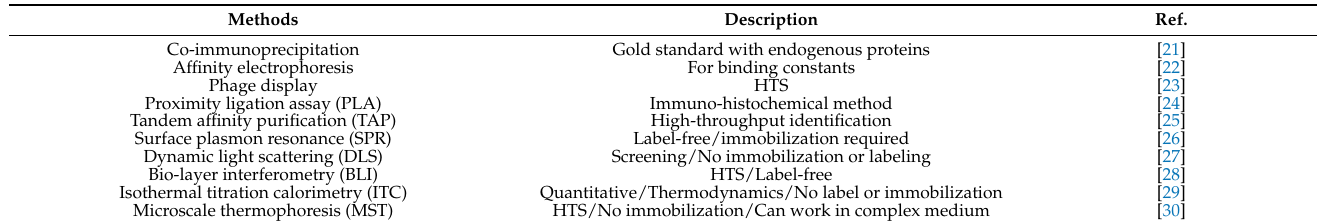
Table 1. Most commonly used biochemical and biophysical methods to investigate PPIs.